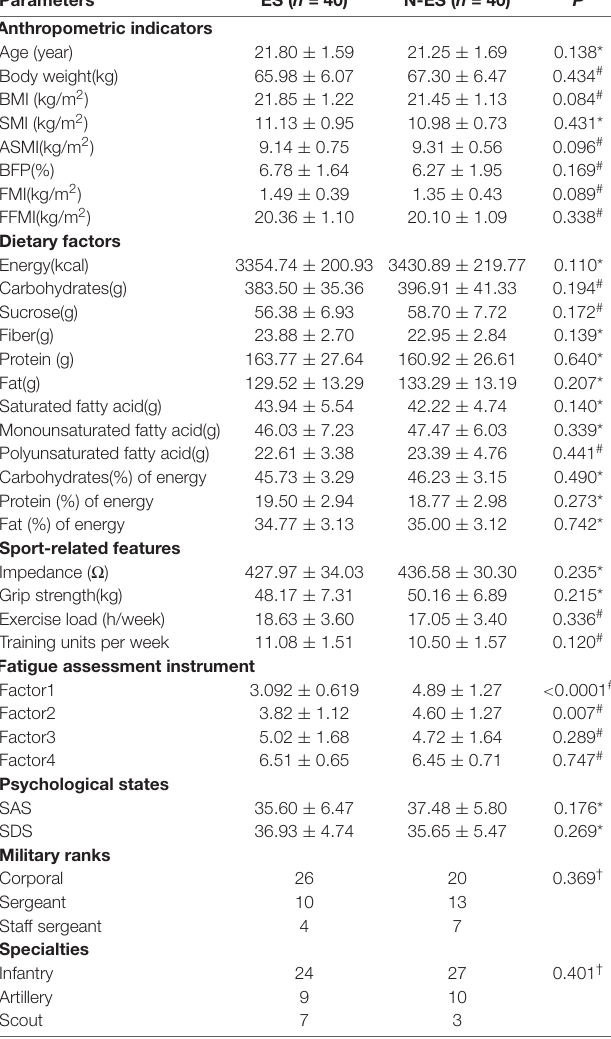
TABLE 1 | Baseline characteristics of subjects used in this